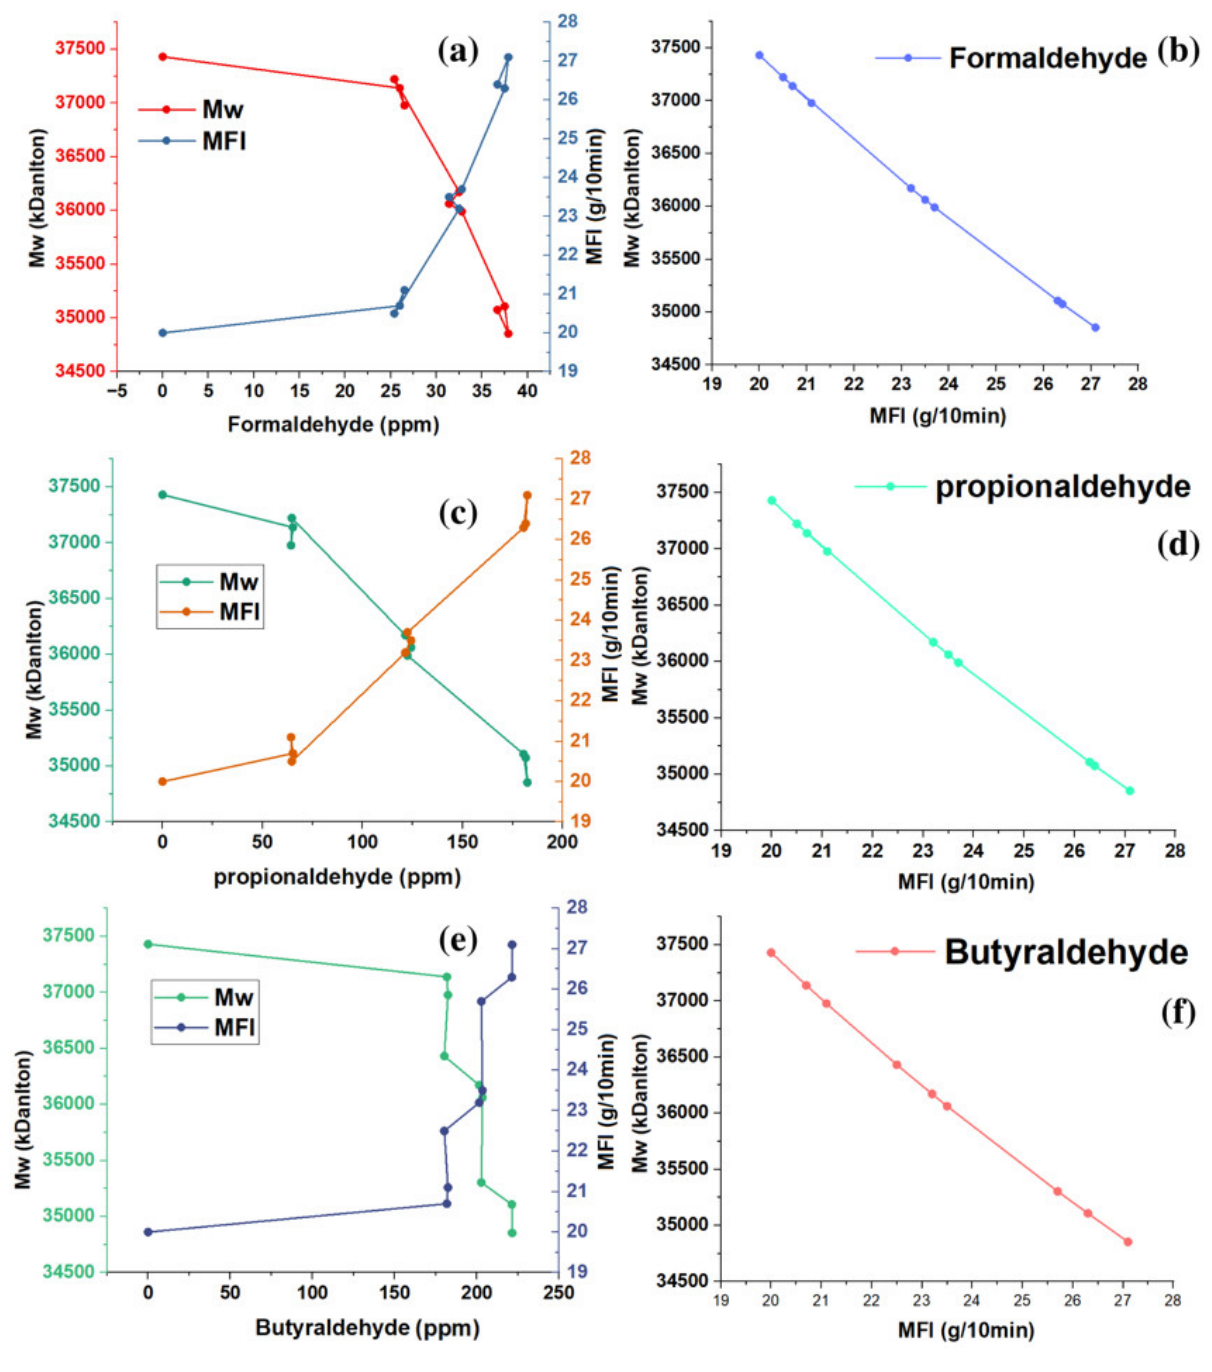
Figure 5. Effect of trace formaldehyde ( a , b ), propionaldehyde ( c , d ), and butyraldehyde ( e , f ), on the MFI and Mv of the copolymer.